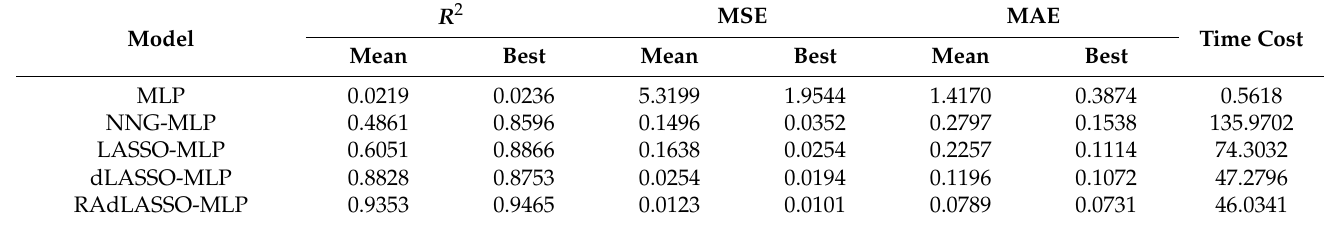
Figure 6. Distribution graph of RON in the measured dataset.